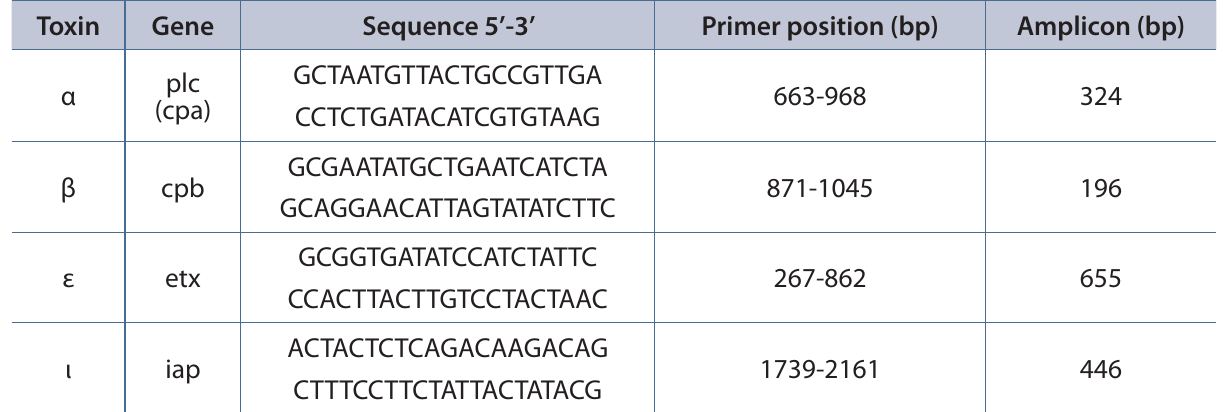
Table 2. Primers employed in multiplex PCR Toxin